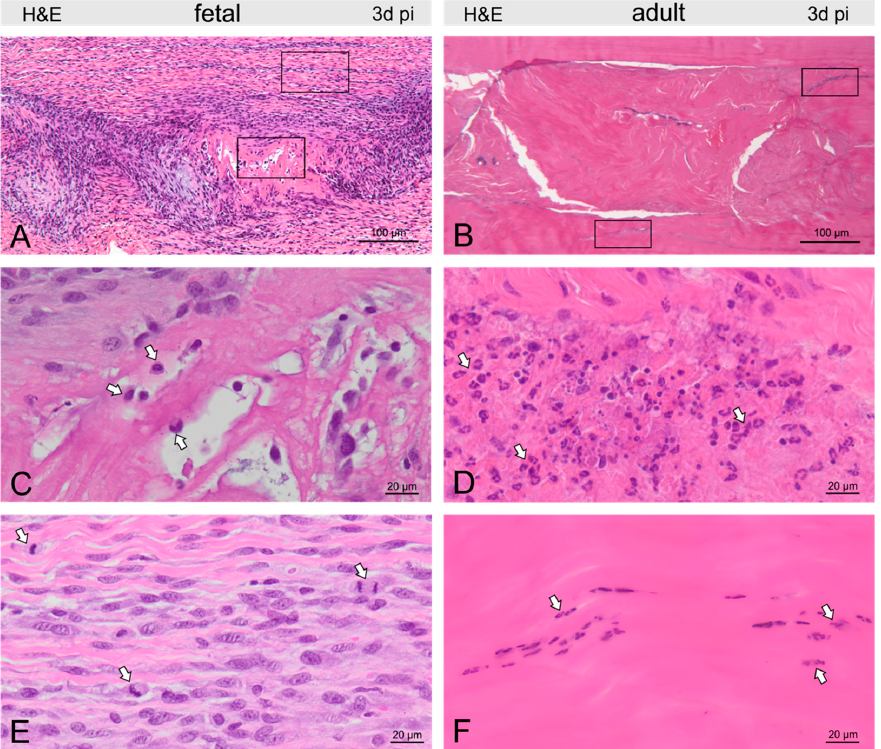
Figure 3. Micrographs show H&E ‐ stained fetal ( A ) and adult ( B ) tendons three days post ‐ injury (pi). Groups of macrophages (arrows) were found in and around the fetal tendon lesion ( C ), while in the adult tendon, nests of granulocytes (arrows) dominated the picture at the lesion site ( D ). In fetal tendons, we found few cells within but more cells around the lesion, also reflected by a remarkable number of mitotic figures (arrows, E ). In adults, tenocytes were reduced in and around the lesion and condensation of chromatin was found in tenocytes (arrows) indicating cell death ( F ).